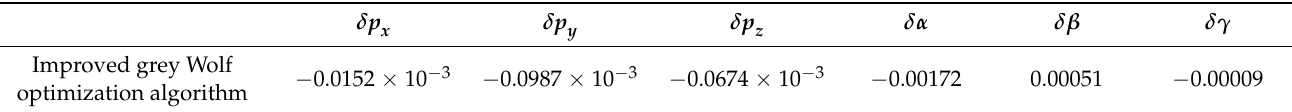
Figure 12. Results of iterations of the GWO and improved GWO algorithms. Table 4. Improved GWO optimization results.